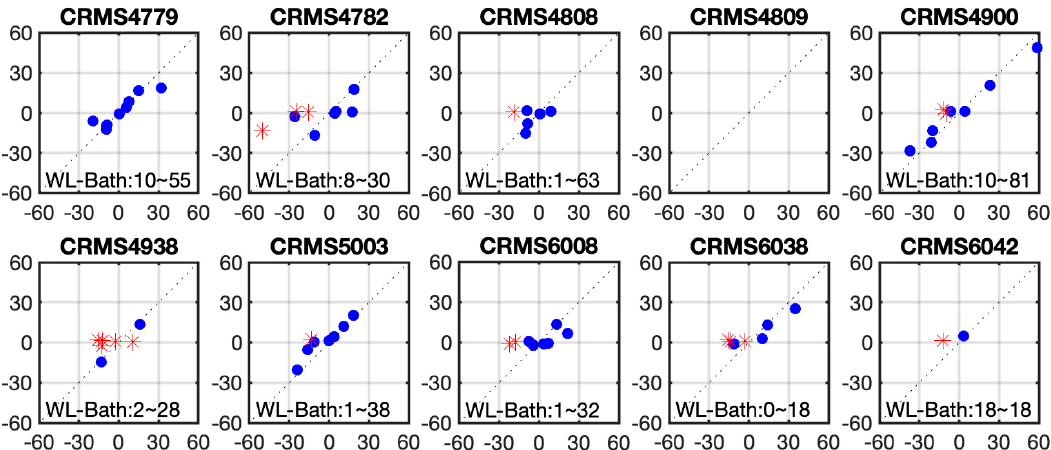
Figure 14. Water level change ( Δ𝑊𝐿 ) retrieval at swamp CRMS stations listed in Table 1 (WL stands for water level and Bath stands for the wetland elevation from USGS DEM. The numerical range in each plot if any is for blue dots only.) (Horizontal axis: Δ𝑊𝐿 Measurement in cm; Vertical axis: Δ𝑊𝐿 Retrieval in cm)